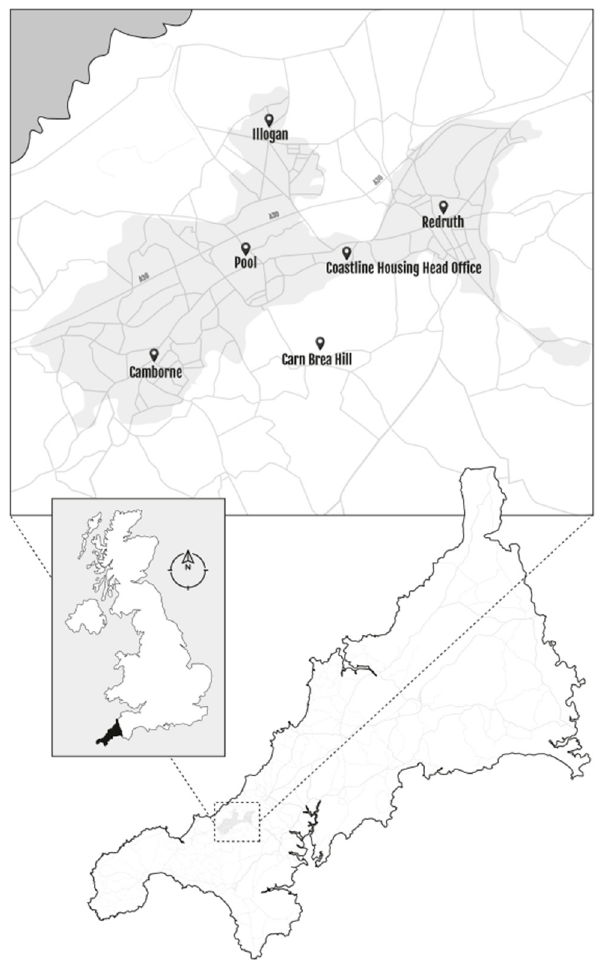
Figure 1. Smartline study location. Reproduced with permission from the primary author [52].